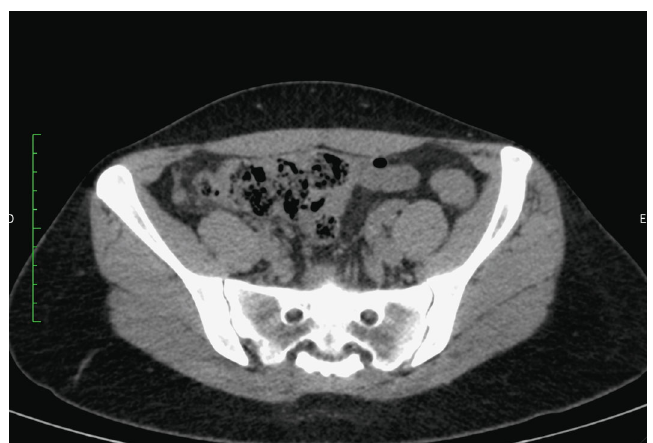
Figure 1: Computed tomography — axial